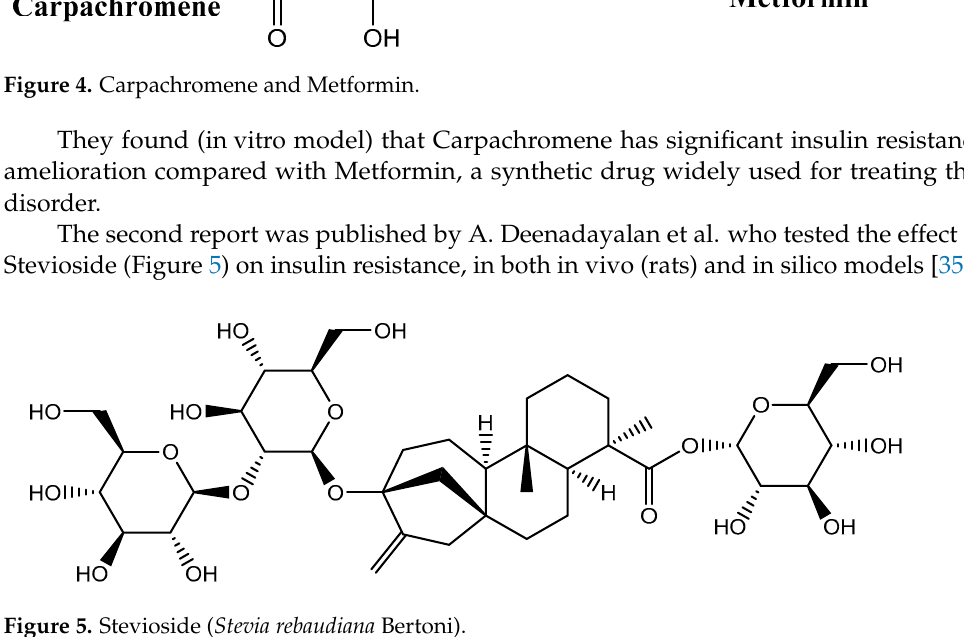
Figure 6. Structures of naturally occurring inositols.